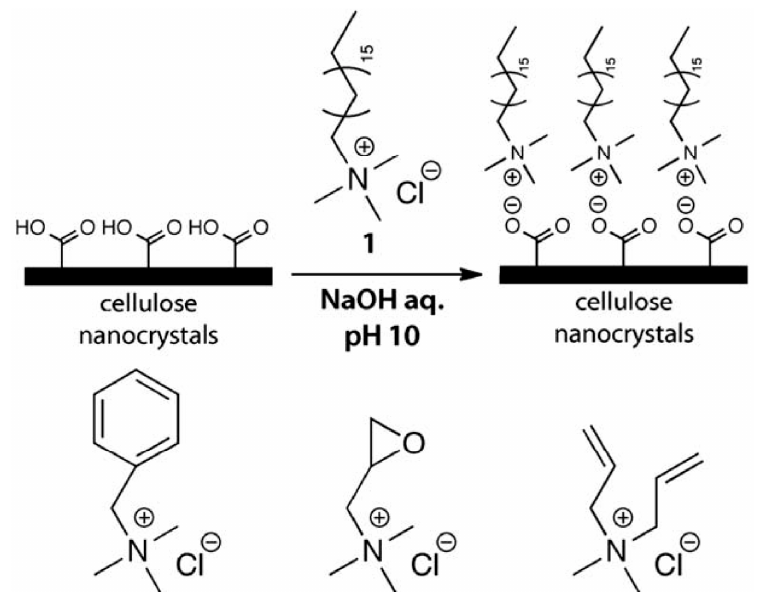
Figure 2. CNC modified by Quaternary Ammonium Salts. Reproduced with permission from Salajková et al. [45]. RSC copyright © 2012.